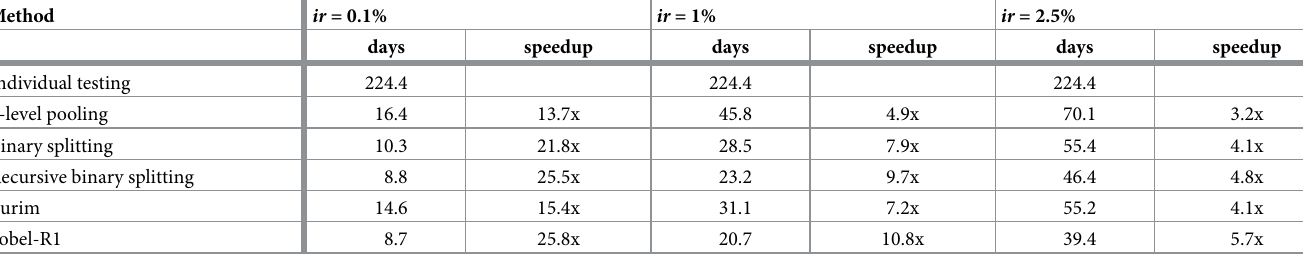
Table 2. Expected time in days to test 10% of the US population for three different infection rates.